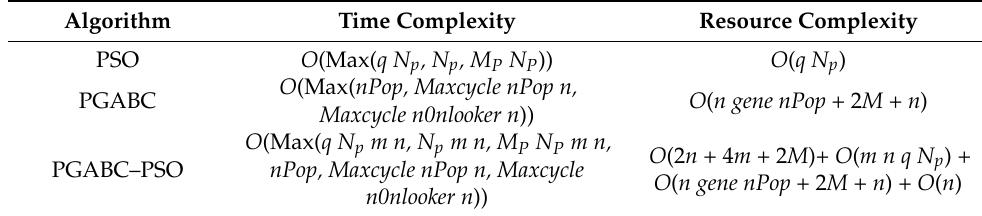
Table 2. Time and resource complexities of